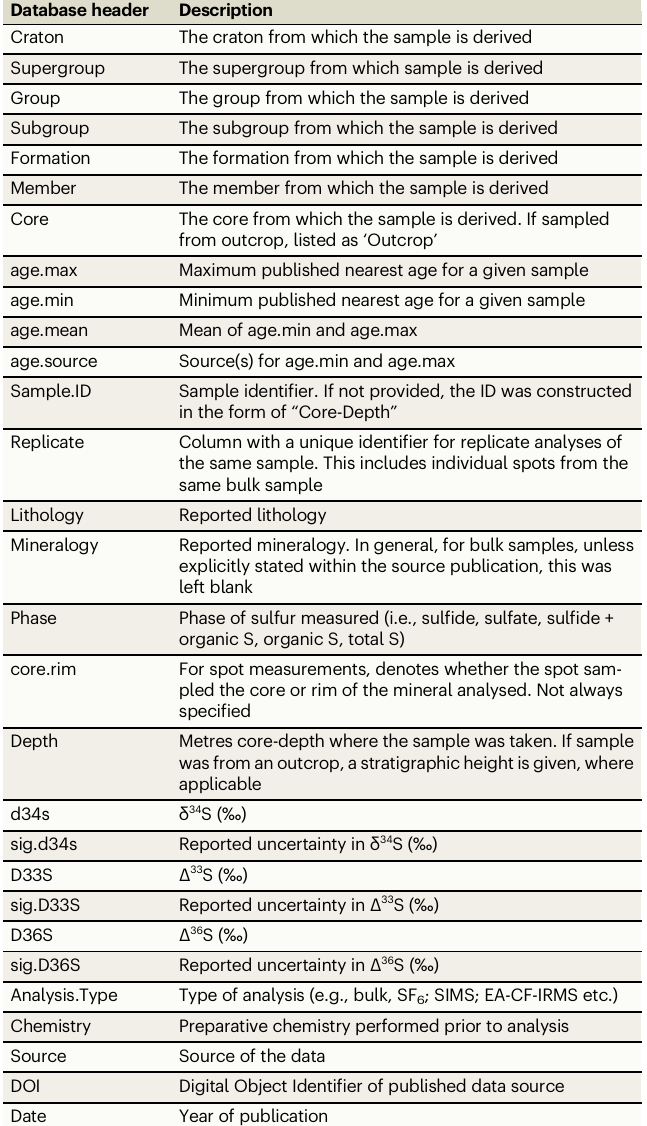
ple sulfur isotope (MSI)